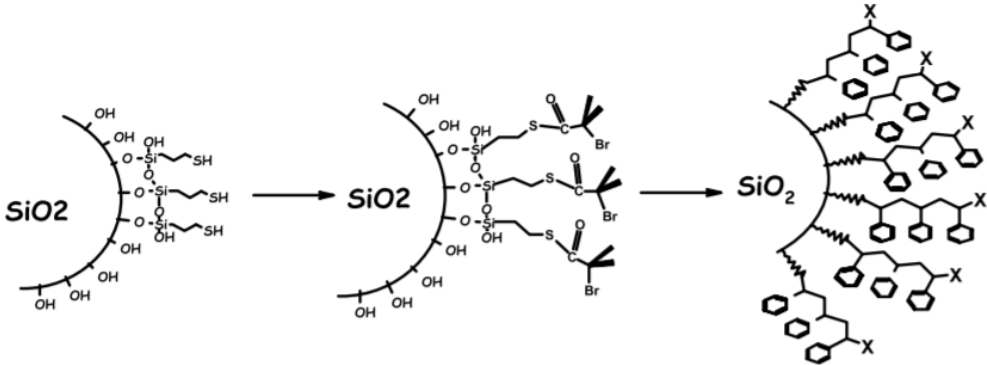
Figure 4. Grafting of the initiator molecule via the ‘over-grafting method’ (reprinted with permission from [39], Copyright 2004, Elsevier).